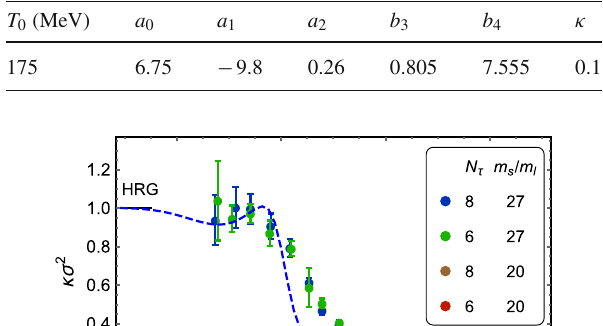
Table 5 Parameters for the Polyakov loop part in the realistic PNJL model